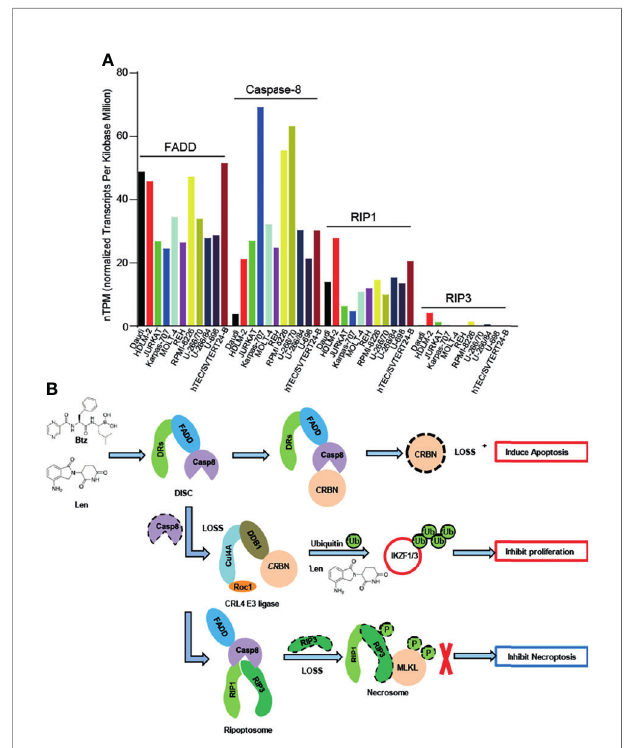
FIGURE 2 | Caspase-8-regulated apoptosis and proliferation of myeloma cells. (A) FADD , Caspase-8 , RIP1 , and RIP3 mRNA expression in lymphoid cell lines. Data were obtained from the Human Protein Atlas (https://www. proteinatlas.org/). (B) Bortezomib (Btz) and lenalidomide (Len) could activate caspase-8 and then cleave CRBN, thereby inducing apoptosis in myeloma cells. When caspase-8 decreased after bortezomib and/or lenalidomide treatment, the CRL4CRBN E3 ligase promoted ubiquitination-mediated degradation of IKZF1/3, thereby inhibiting the proliferation of myeloma cells. Due to the low expression of RIP3 in myeloma cells, necrosomes could not be formed and, therefore, necroptosis was